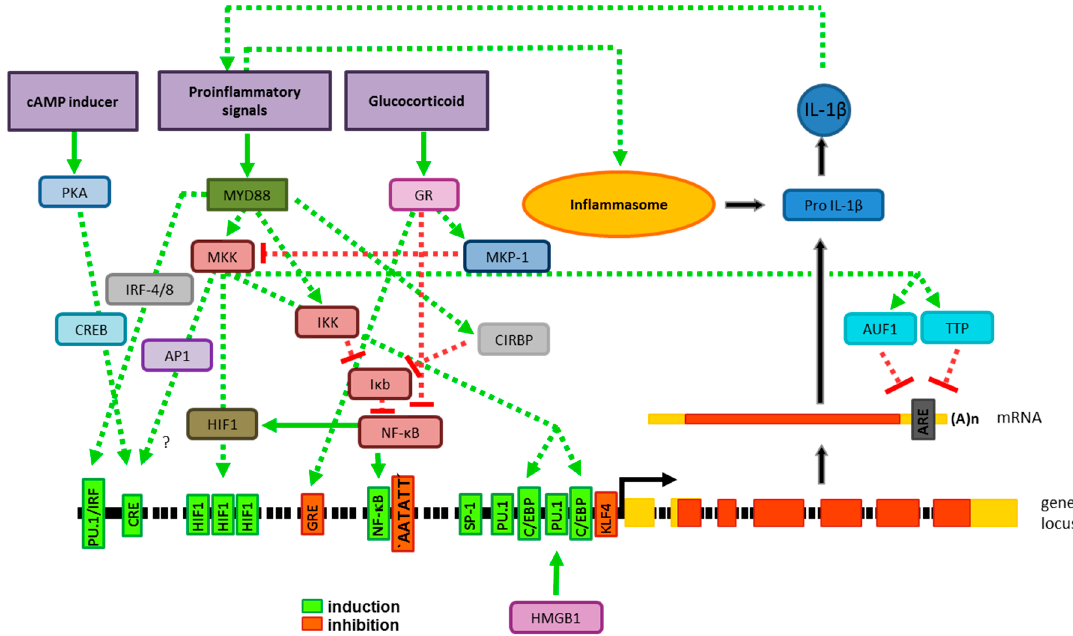
Figure 1. IL-1 β expression. Transcriptional and posttranscriptional regulation results in expression of functionally inactive pro-IL-1 β . Stimulatory (green) and inhibitory (red) activities exerted by stimuli, signaling adaptors and TF are indicated by arrows. TF binding sites (boxes) within the IL-1 β gene promoter that induce (green) or inhibit (orange) gene expression are named. The transcription start site is drawn (black arrow). Exons (boxes) encompass non-coding (yellow) and protein-coding (orange) regions. The derived IL-1 β mRNA, and the location of the AU-rich elements (ARE) engaged by RNA-binding proteins are depicted. Pro-IL-1 β is cleaved by active inflammasomes which yields bioactive IL-1 β .